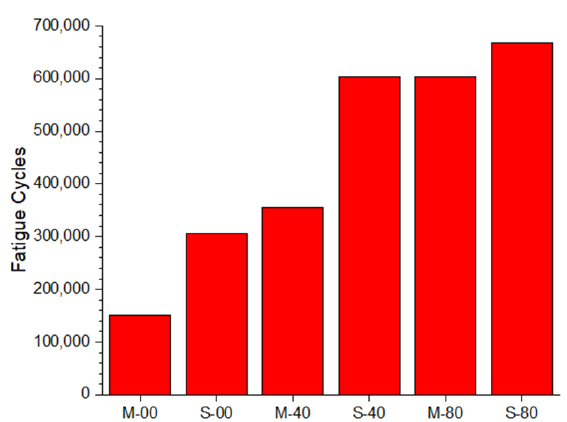
Figure 6. Average number of fatigue cycles to the end of the 4PB fatigue tests at either 50% sti ff ness modulus lost or 1 million cycles limit. modulus lost or 1 million cycles limit.